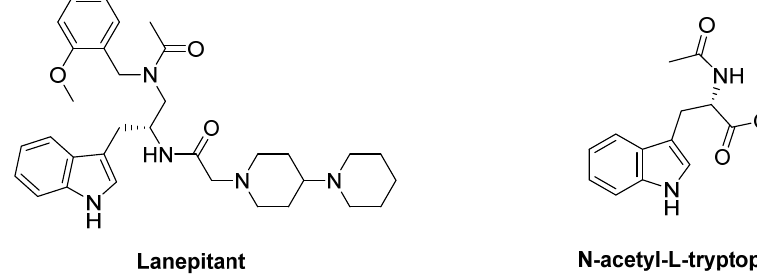
Figure 16. Neurokinin receptor ligands.